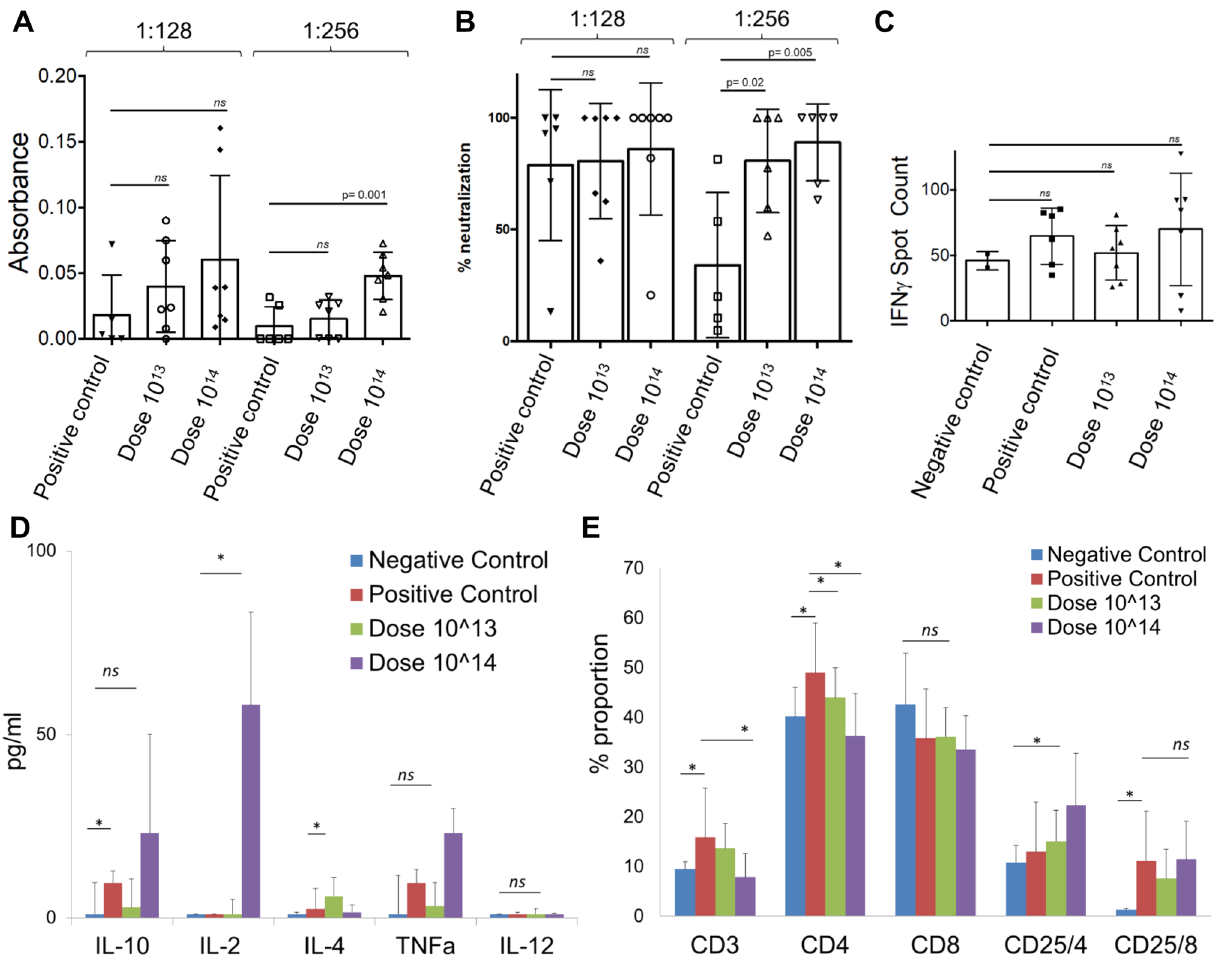
Figure 5. In vitro efficacy analysis of serum and spleen T cell isolated from challenge applied mice. ( A ) The bar graph showing the presence (absorbance) of SARS-CoV-2 specific IgG in the mice sera diluted with either 1:128 or 1:256 detected using ELISA. ( B ) The bar graph showing the neutralization frequency of the mice sera diluted to 1:128 or 1:256 that were pre-incubated with a 100 × TCID50 dose of infective SARS-CoV-2. The analysis was performed with MTT analysis at 96 h. ( C ) The bar graph showing the activation frequency (IFNγ positive spot count) of spleen T cells that were incubated with SARS-CoV-2 specific peptides. ( D ) The bar graph showing cytokine (IL-10, IL-2, IL-4, TNFa, and IL-12) proportions of spleen T cells that were incubated with SARS-CoV-2 specific peptides. ( E ) The bar graph showing a change in the frequency of the T cells after the stimulation. The activation of the T cells was determined with the upregulation of the CD25 surface